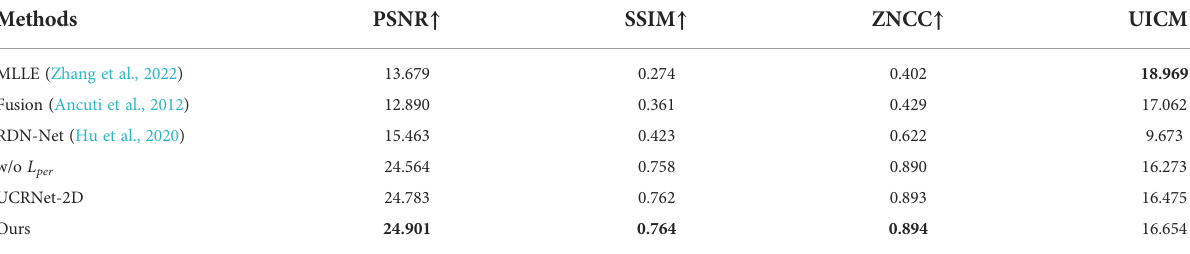
TABLE 2 Quantitative comparisons of different